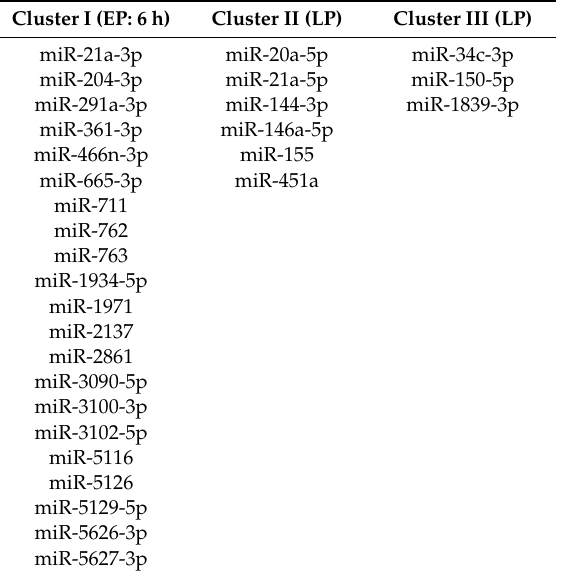
Table 1. The members of the three clusters based on the two-way hierarchical clustering. Cluster I: miRNAs jointly upregulated in EP groups at 6 h, Cluster II: miRNAs jointly upregulated in LP groups, Cluster III: miRNAs jointly downregulated in LP groups. Grey highlight: miRNAs identified also by the analysis of ranking.